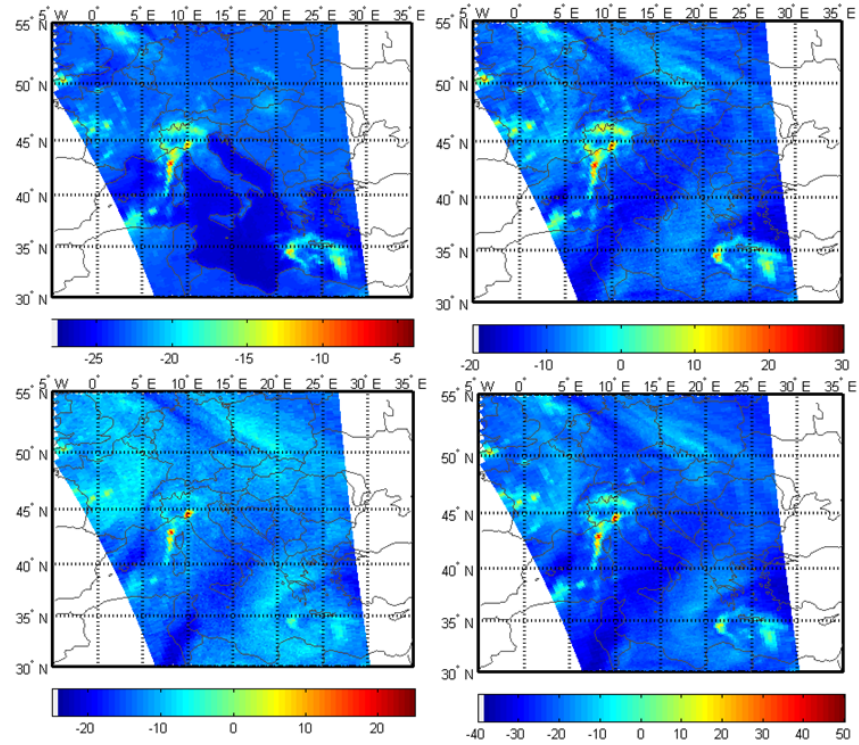
Figure 6. Flood over the La Spezia area (Italy, 44 ◦ N, 10 ◦ E), 25 October 2011, 11:44UTC. Maps of the four inputs data to the NN derived from the AMSU-A/MHS TBs: LCT (top left), (cid:49) 37 (top right), (cid:49) 13 (bottom left) and (cid:49) 17 (bottom right).